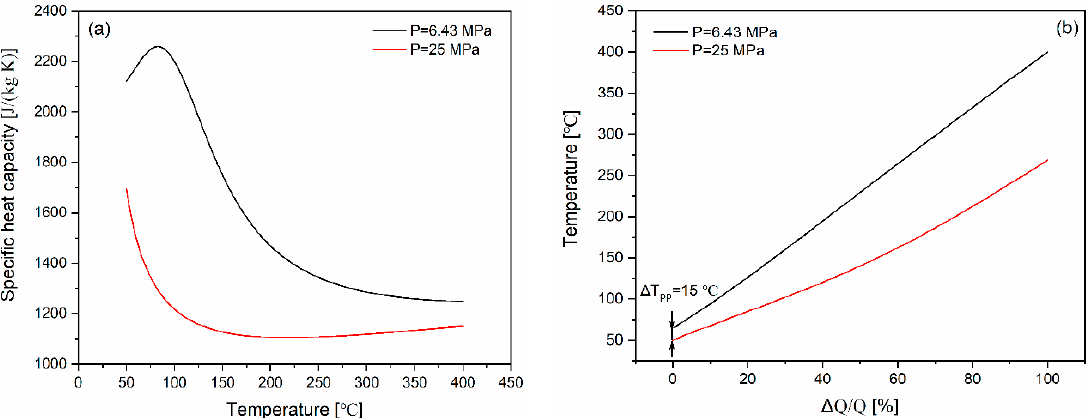
Figure 1. The ( a ) specific heat capacity and ( b ) temperature match of the two sides in the recuperator of CO 2